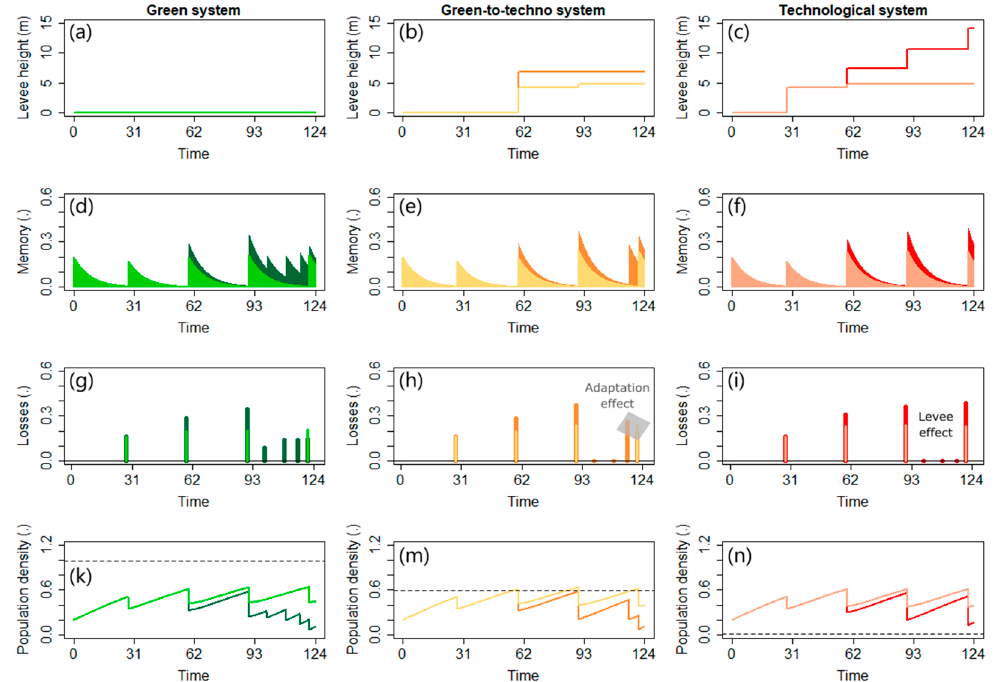
Figure 12. Levee height ( H ), collective memory ( M ), flood losses ( FD ), and population density ( D ) dynamics of green ( a , d , g , k ), green-to-techno ( b , e , h , m ), and technological ( c , f , i , n ) systems. The lighter colour indicates scenario 1 and the darker colour indicate scenario 4. Dashed lines indicate the values of the δ D parameter.